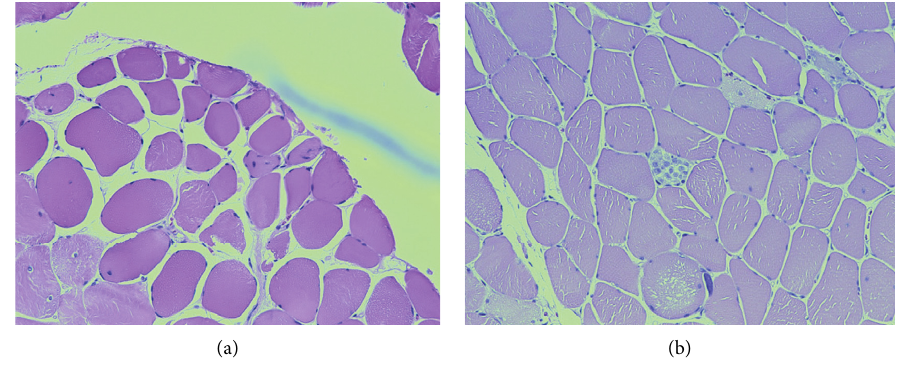
Figure 1: Regenerating (a) and degenerating (b) muscle fibers at 20 x